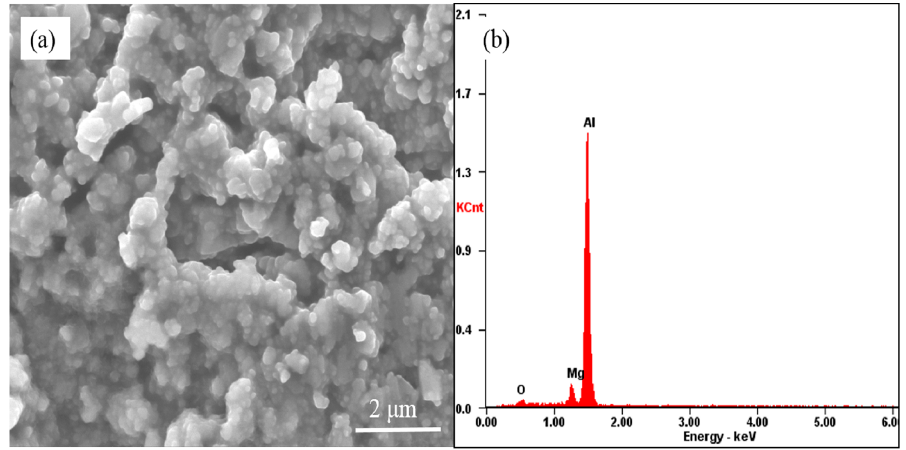
Figure 9. ( a ) The surface micro-morphology of 5083 alloy scraps; ( b ) Corresponding EDS results.